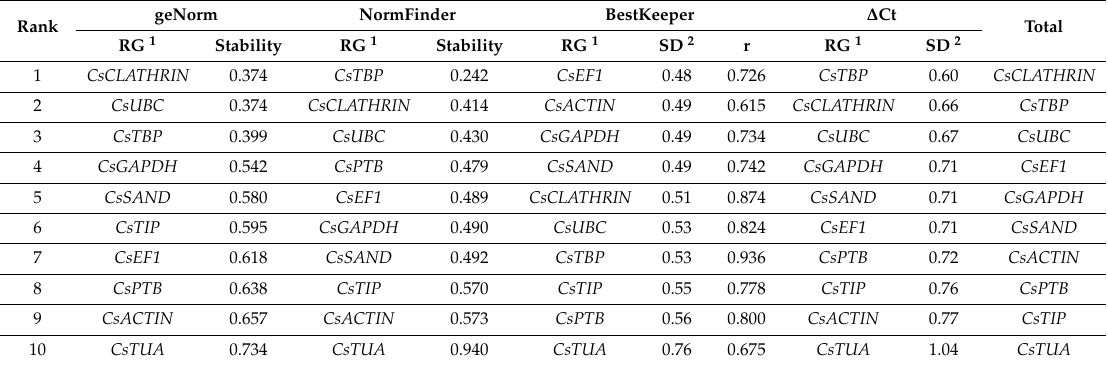
Table 1. Ranking of the reference genes expression under JA-Ile-macrolactones treatment.